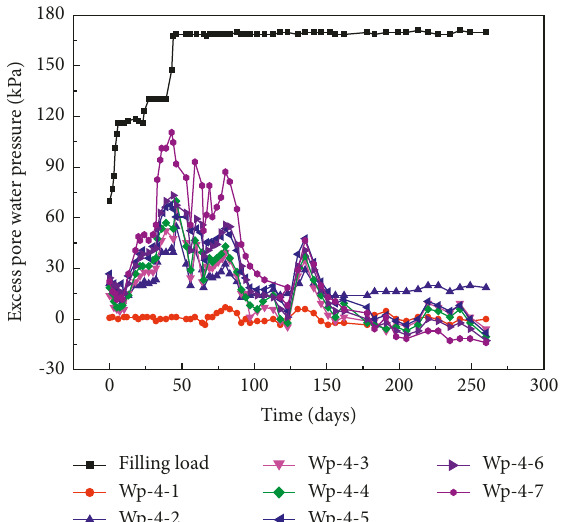
Figure 8: Relationship between excess pore water pressure and the